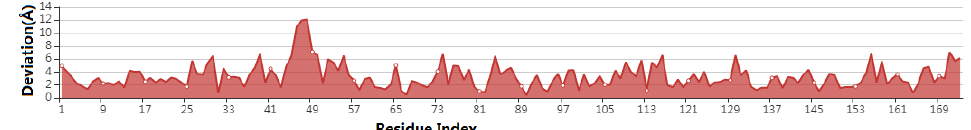
Figure 5. The area chart shows the deviation of a certain protein chain after alignment.